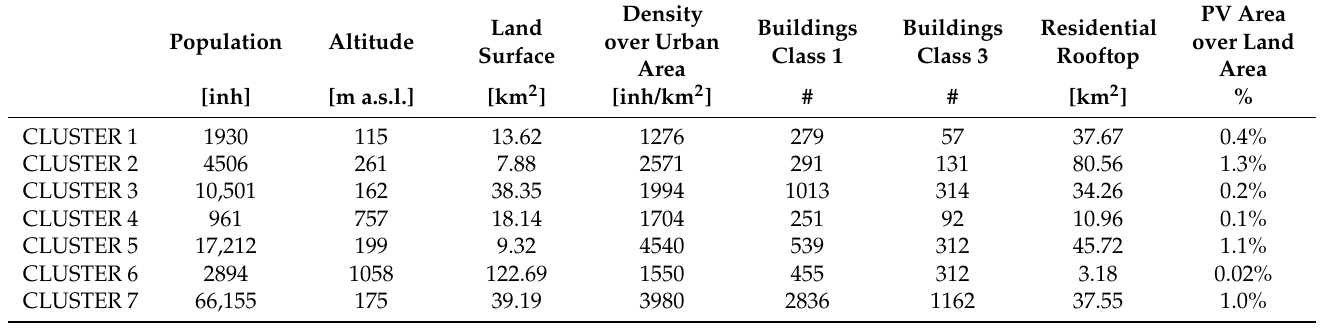
Table 2. Summary of cluster characteristics. Average values of cluster features and the total output values of residential rooftop surface and as percentage of the land surface.